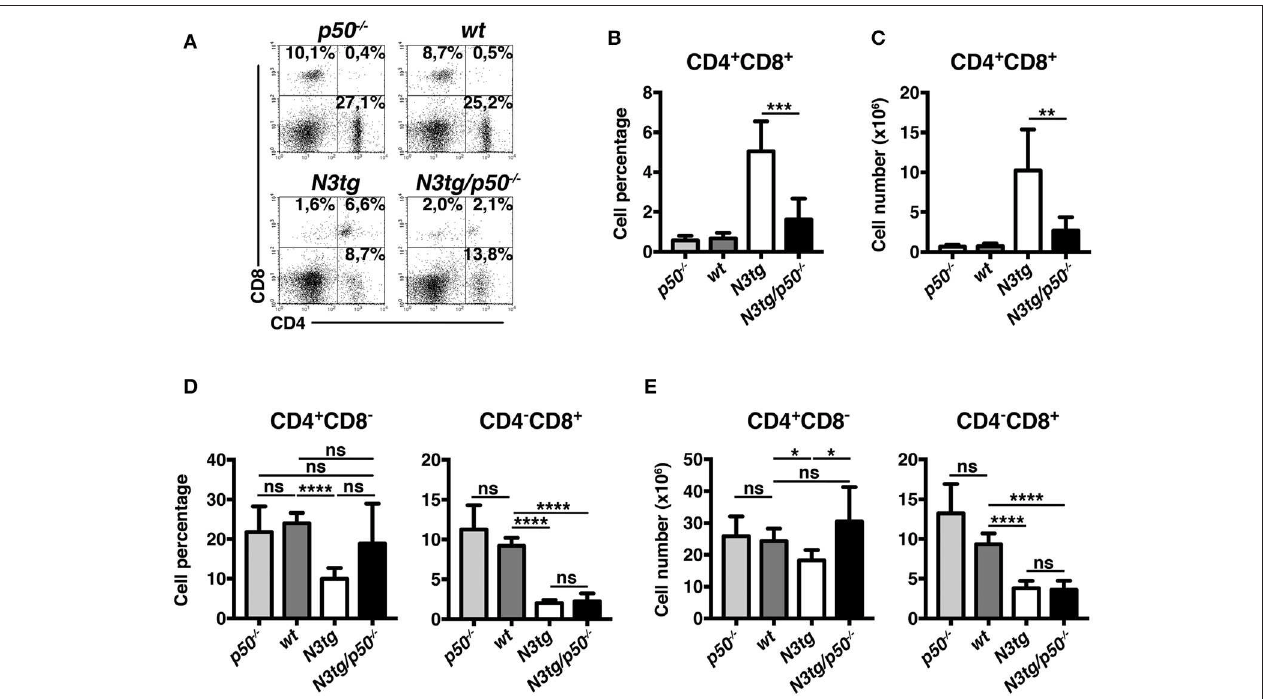
FIGURE 7 | NF- κ B1 deletion decreases CD4 + CD8 + (DP) T cell numbers in the spleen of N3tg/p50 − / − vs. N3tg mice . (A,B) Percentages and (C) absolute numbers of DP T cells in the spleen of N3tg/p50 − / − , N3tg , p50 − / − , and wt mice at 4–5 weeks of age, as measured by FACS analysis of CD4 vs. CD8 distributions. In (A) numbers inside each cytogram represent the percentages of different cell subsets. (D) Percentages and (E) absolute numbers of CD4 + CD8 − and CD4 − CD8 + subsets in the spleen of N3tg/p50 − / − , N3tg , p50 − / − and wt mice, measured as in (A) . In (B–E) results are shown as mean ± SD of five independent experiments ( n = 6 mice per group). ns = not significant; * P ≤ 0.05, ** P ≤ 0.01, *** P ≤ 0.001 and **** P ≤ 0.0001 represent significant differences between the indicated